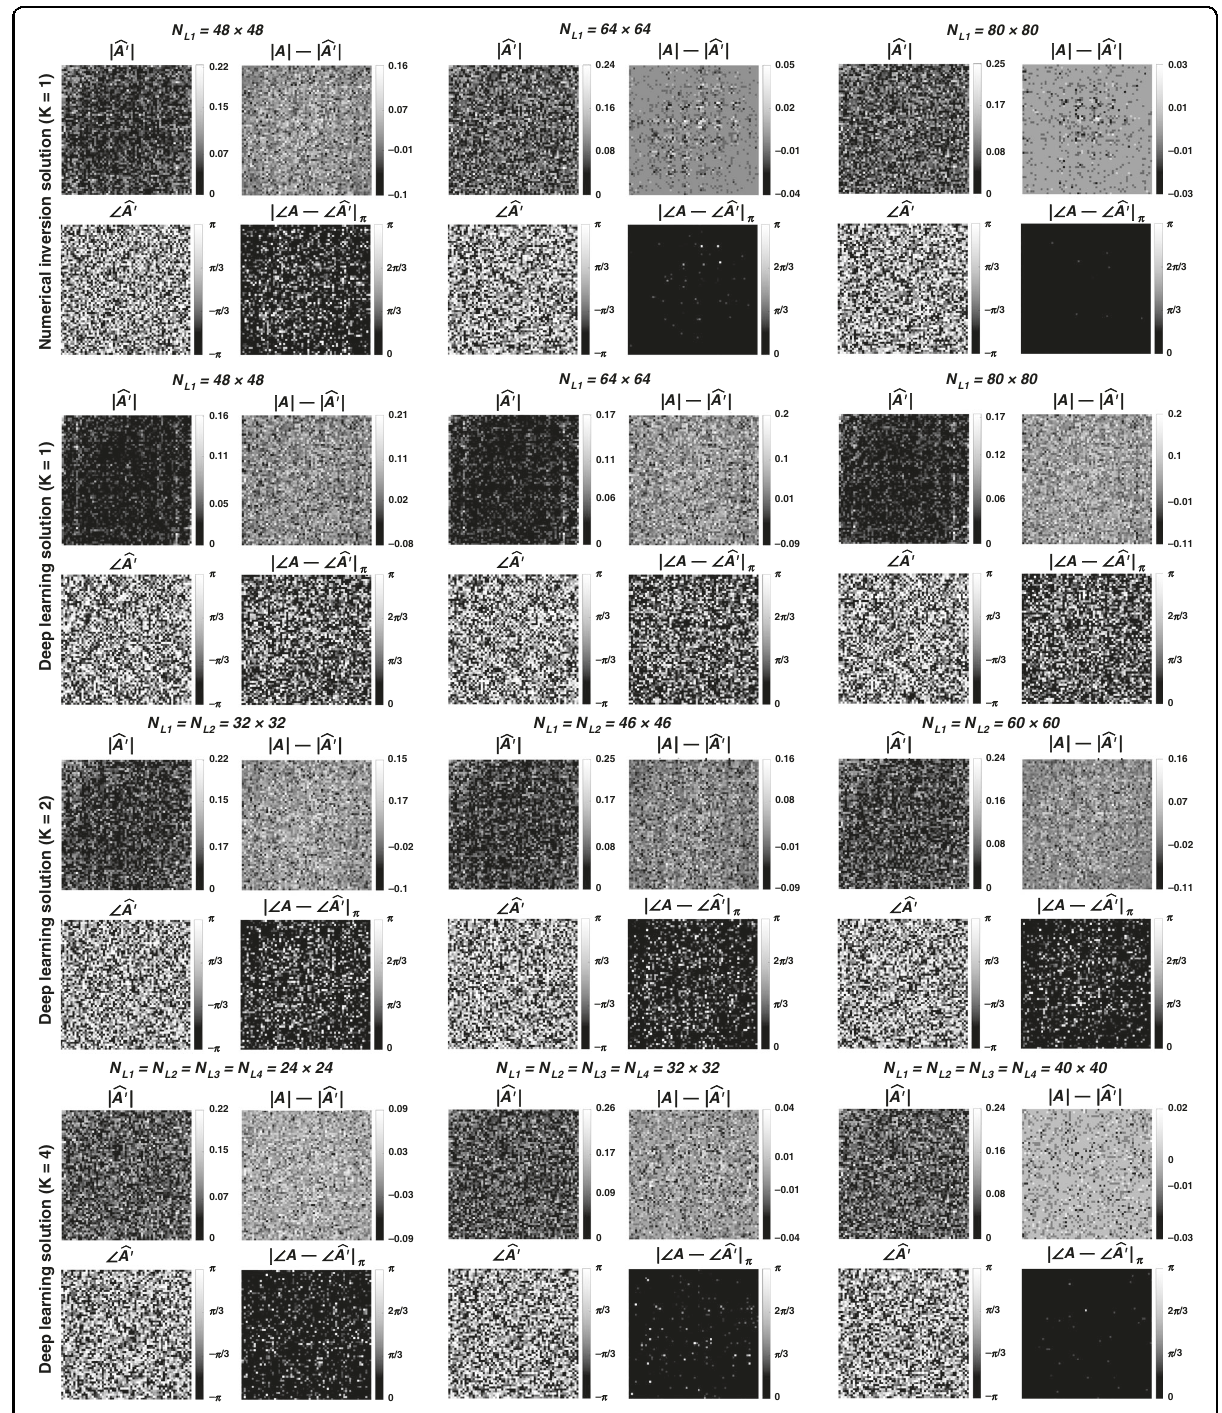
Fig. 5 Diffractive all-optical transformations and their differences from the ground truth, target transformation (A) presented in Fig. 4b. (cid:5) (cid:5) (cid:5) (cid:5) (cid:5) (cid:5) indicates the wrapped phase difference between the ground truth and the normalized all-optical ff A (cid:2) ff b A ′ π